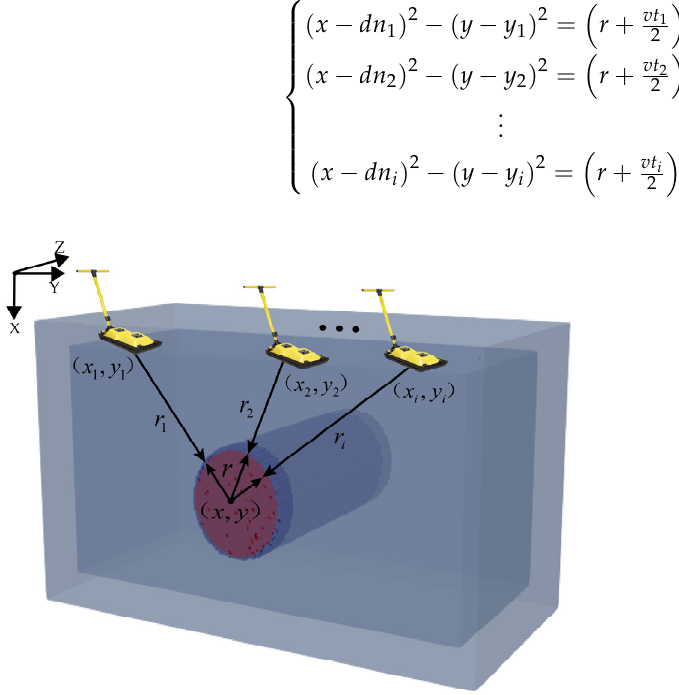
Figure 5. TPFC method schematic diagram.